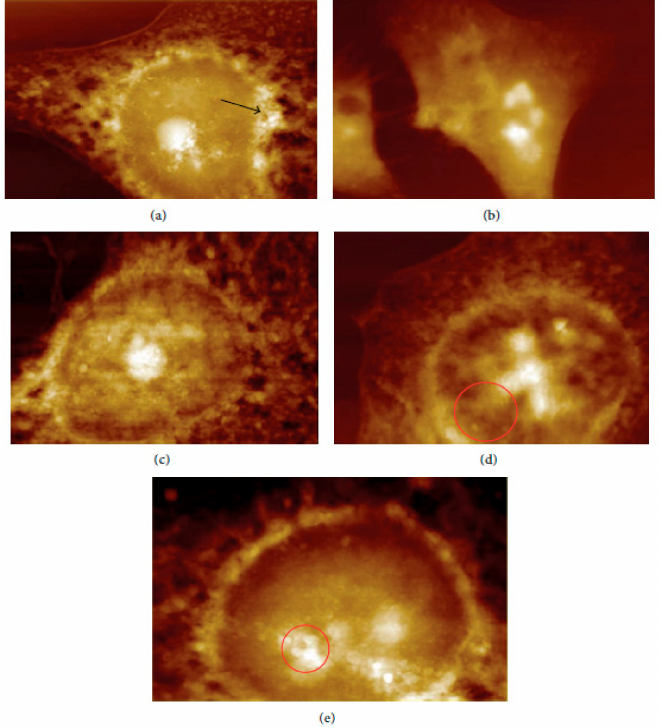
Figure 4. AFM images of 25-nm gold NPs into Hep-2 cells after different exposure times: ( a ) 1, ( b ) 2, ( c ) 4, ( d ) 12, and ( e ) 24 h